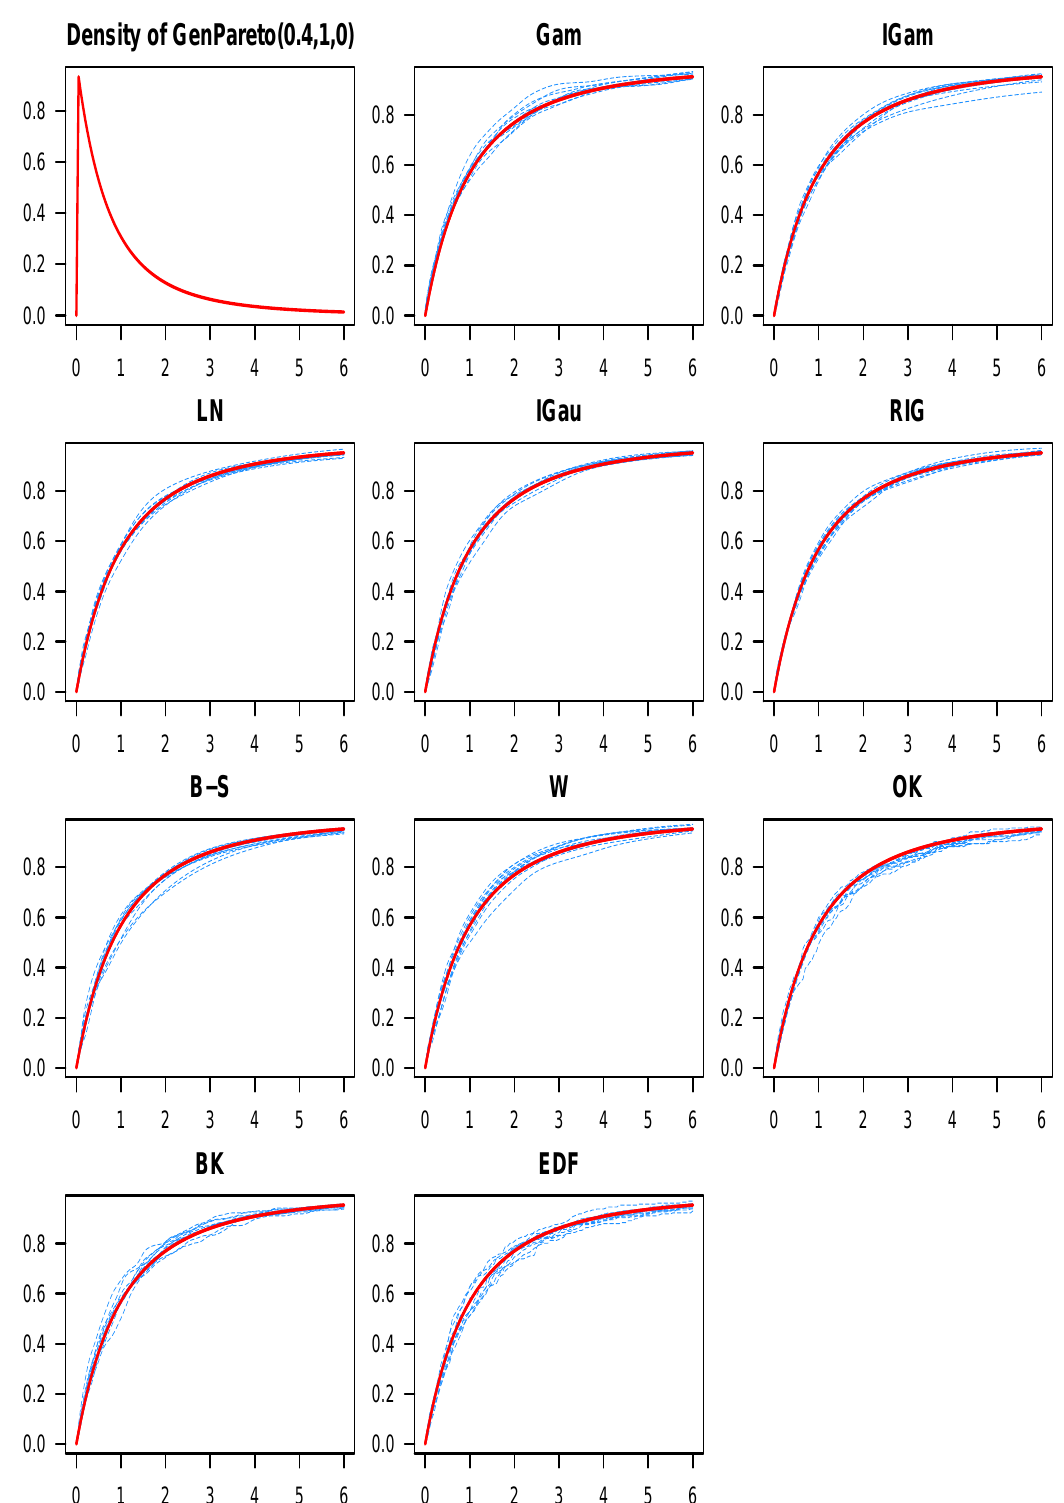
Figure 5. The GeneralizedPareto ( 0.4,1,0 ) density function appears on the top-left, and the target c.d.f. is depicted in red everywhere else. Each plot has ten estimates in blue for the GeneralizedPareto ( 0.4,1,0 ) c.d.f. using one of the ten estimators (the name of the corresponding kernel is indicated above each graph) and n =